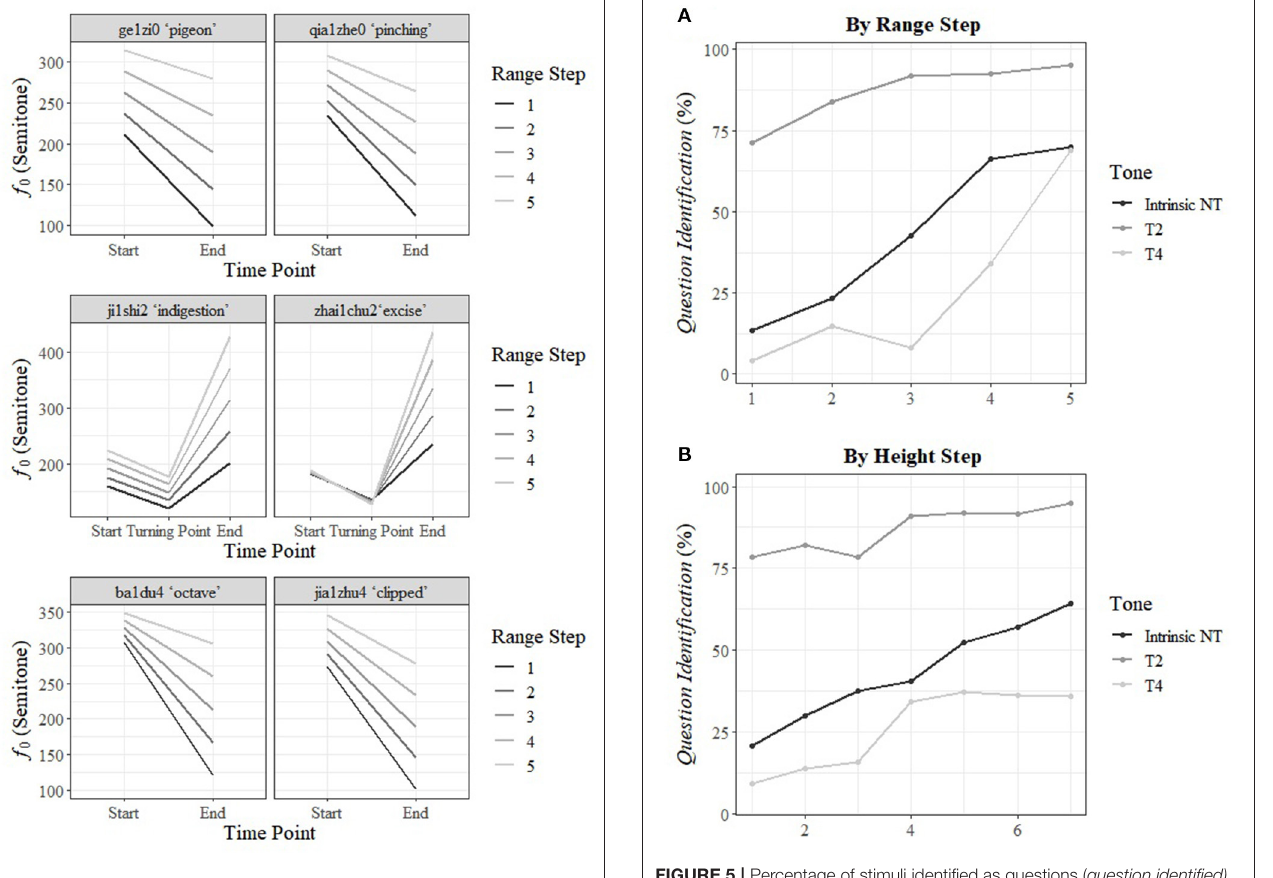
FIGURE 4 | Range steps of each stimulus at Height Step 1.